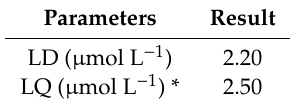
Table 6. Limit of detection and quantification of the analytical method for Ethinyl estradiol.